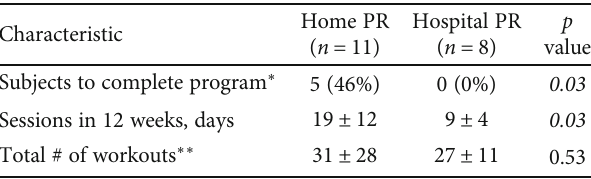
Table 2: Adherence to the exercise